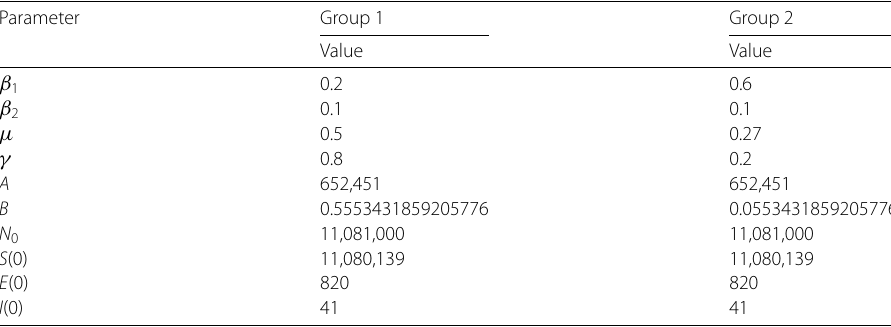
Table 2 The value of the parameters used in the model and the initial values Parameter Group 1 Group 2 Value Value β